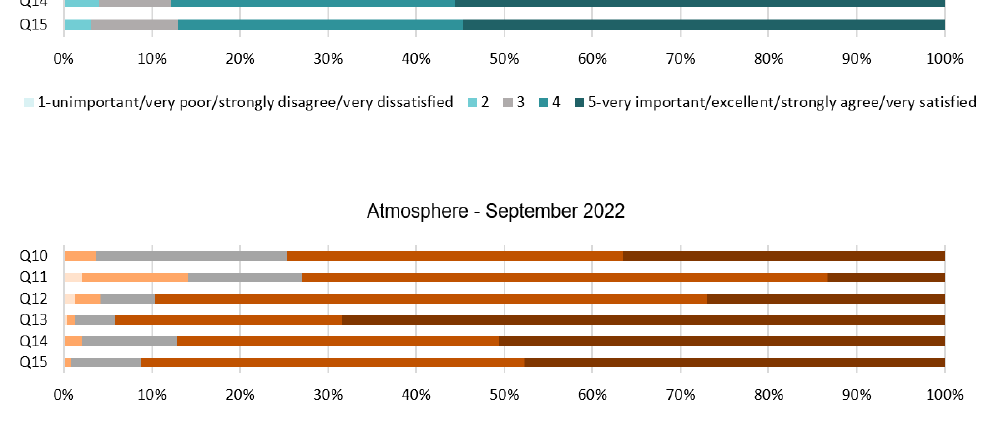
Table 5. Interval data analysis of the Spaciousness dimension.